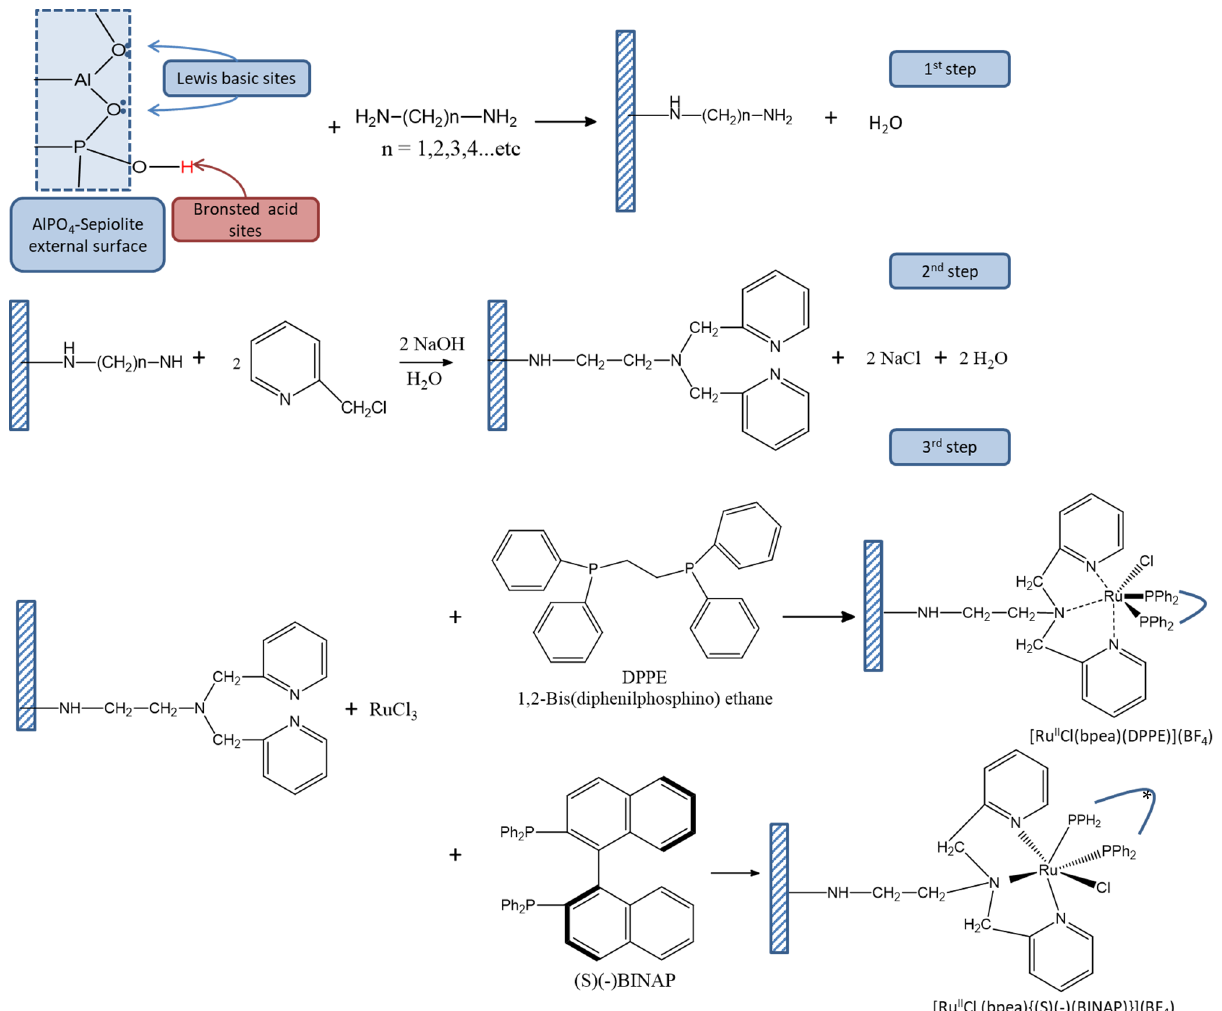
Scheme 1. General scheme for the covalent immobilization of homogeneous Ru II Cl(bpea){(S)(-)(BINAP)}](BF 4 ), 1 and [Ru II Cl (bpea)(DPPE)](BF 4 ), 2 complexes on AlPO 4 -Sepiolite.